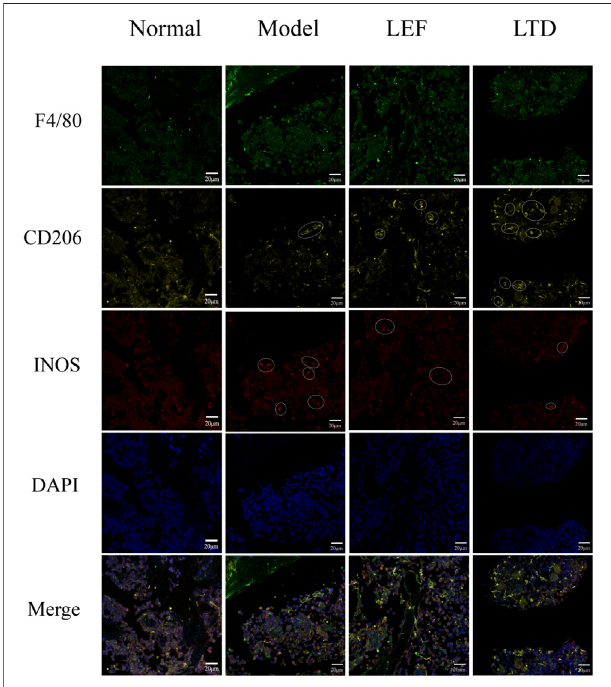
FIGURE 8 | Immuno fl uorescence images of macrophage distribution. Thewhitecircles represent positivecells. Thescalebarcorresponds to20 µm